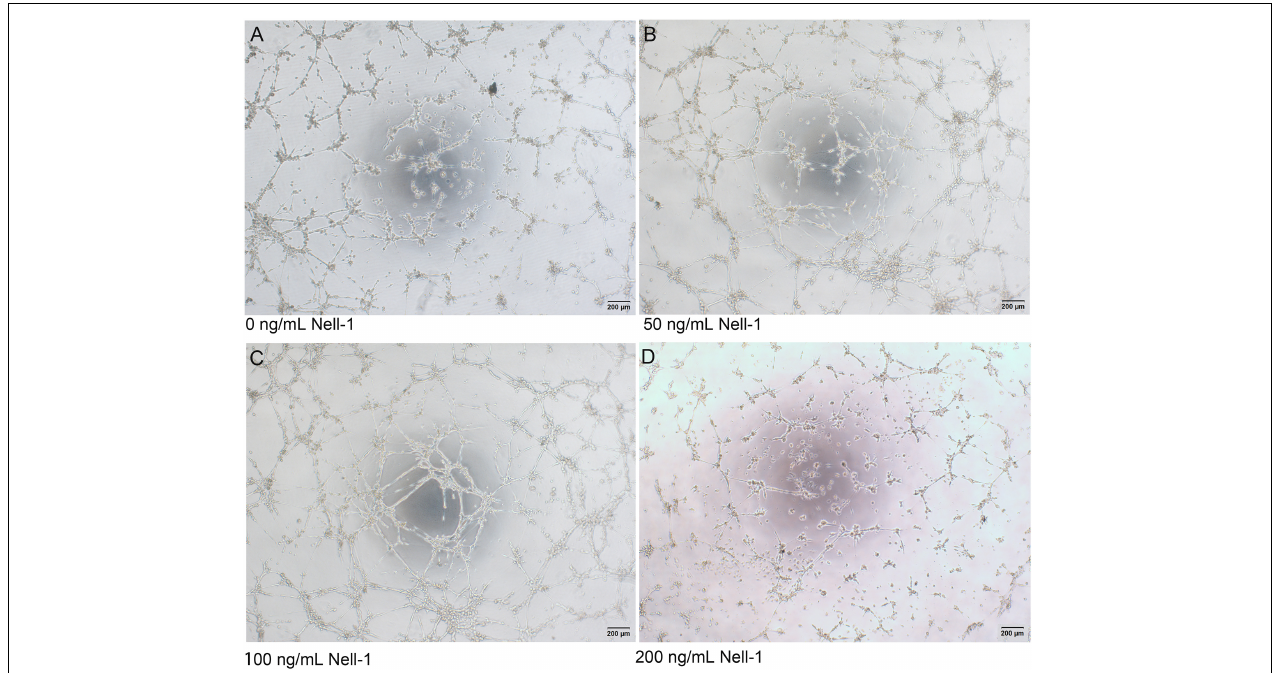
FIGURE 4 | In vitro tube formation assay. (A–D) Phase-contrast images ( × 40) of mixed cells with 0, 50, 100, and 200 ng/mL Nell-1 at 6h after seeding on Matrigel. Compared with control group (A) , 50 and 100 ng/mL Nell-1 group (B,C) showed more number of branching points and tubular length while 200 ng/mL Nell-1 group (D) had no significant changes.